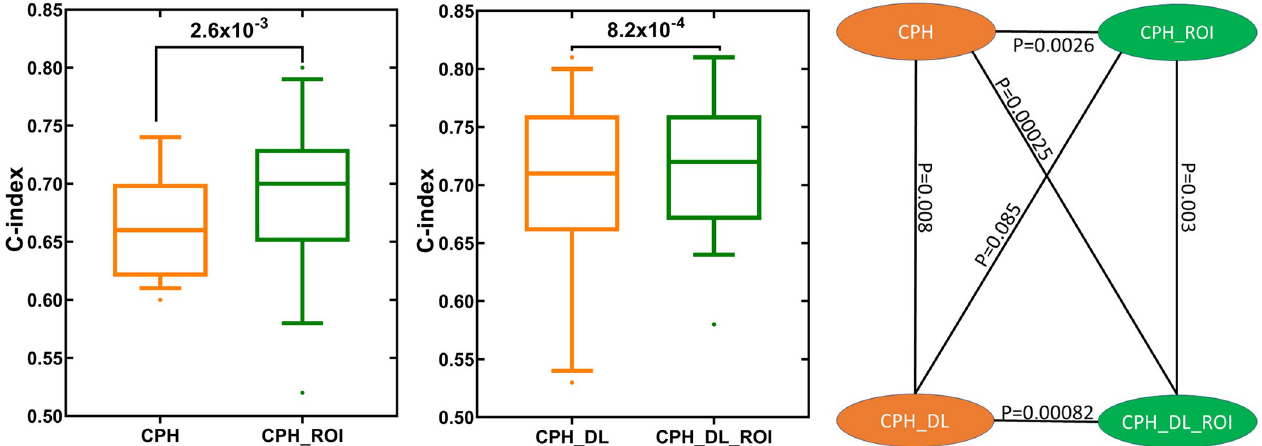
Fig 1. TTE prediction performance comparison between models with and without the related outcome incorporator (ROI). Each box plot shows the distribution of C-index values for the 19 TTE prediction tasks (Table 1). The p values were calculated using one-sided Wilcoxon signed-rank test.